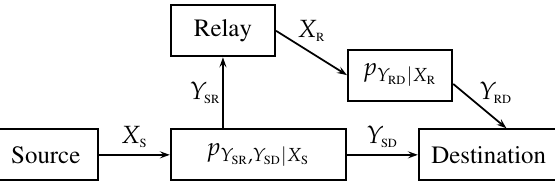
Figure 1. General relay channel.